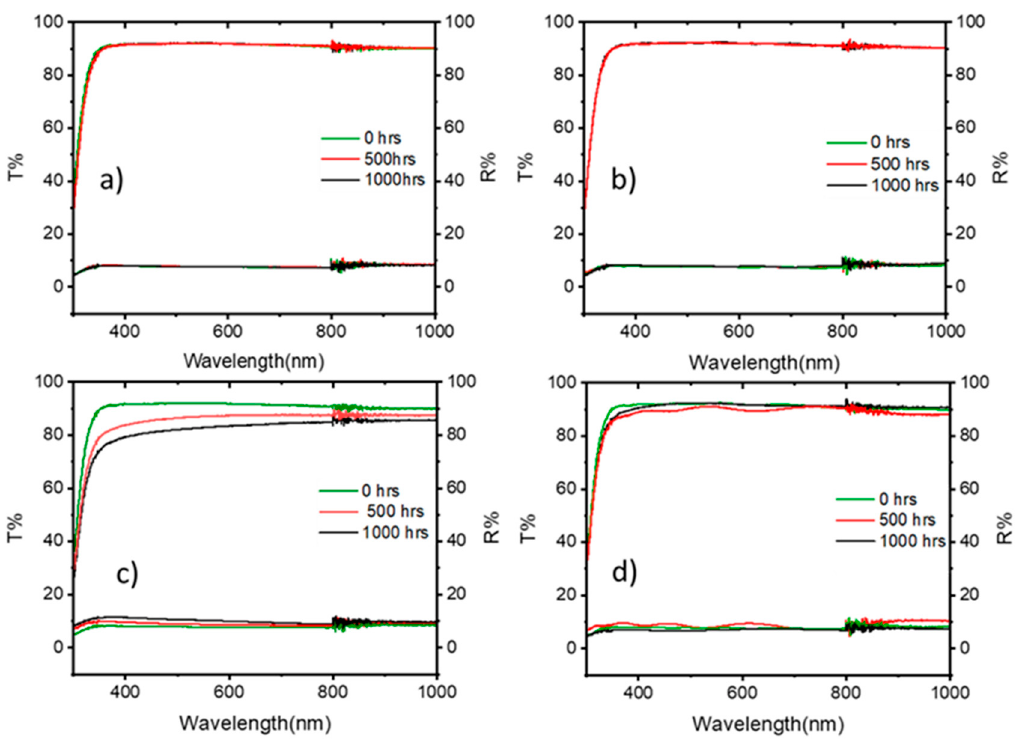
Figure 9. Transmittance (%T) and reflectance (%R) measurements for UV-exposed, ( a ) spray-coated, and ( b ) dip-coated hydrophobic coatings; transmittance (%T) and ( d ) reflectance (%R) of DH-exposed ( c ) spray-coated, and ( d ) dip-coated hydrophobic coatings.